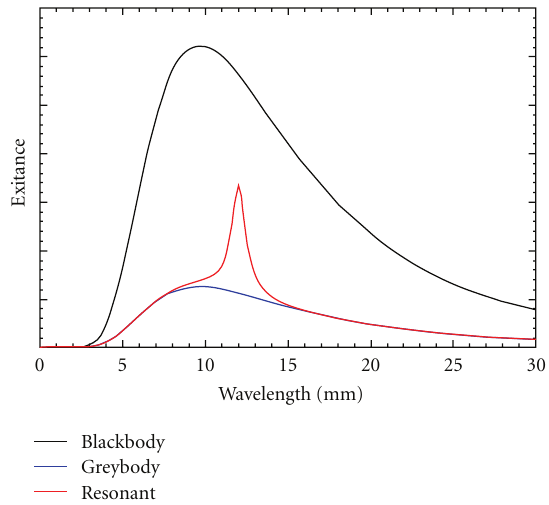
Figure 1: Notional diagram that illustrates the normally smooth thermal exitance curves from blackbody and graybody objects compared to the resonant behavior of our “engineered” IR resonant